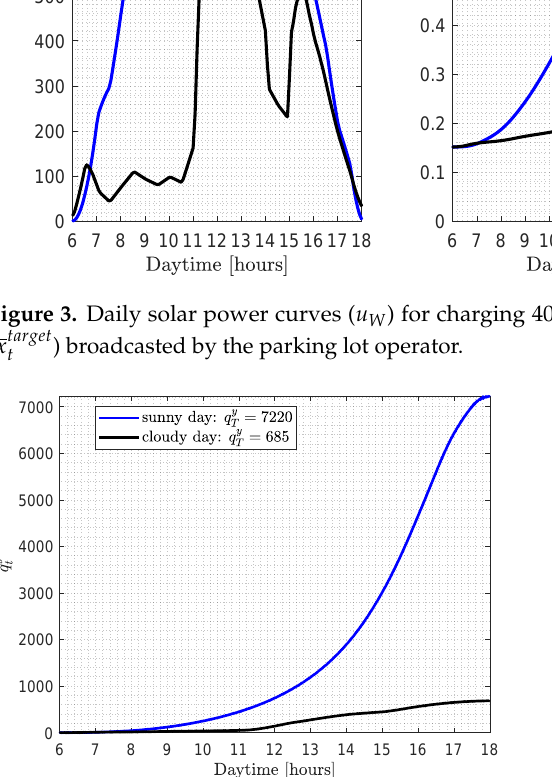
) of a fixed population of 400 t